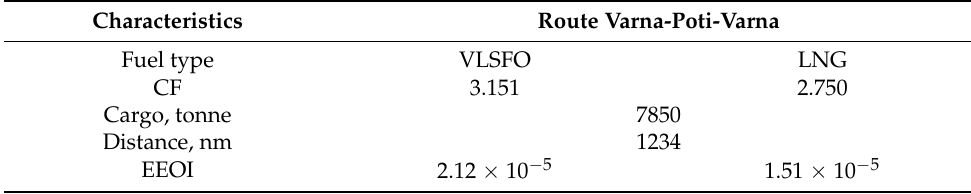
Table 9. Summary for EEOI for the considered